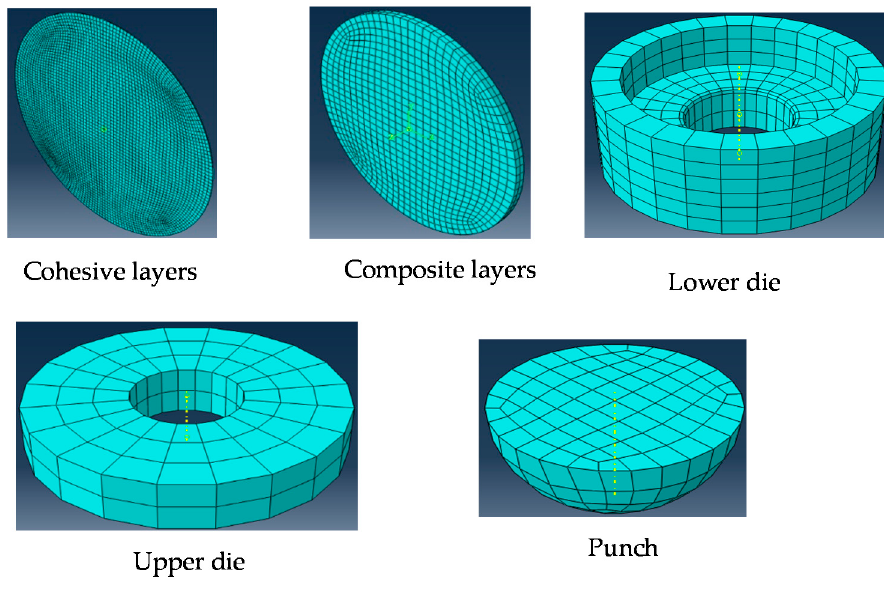
Figure 5. Mesh of the different elements of the FE model.